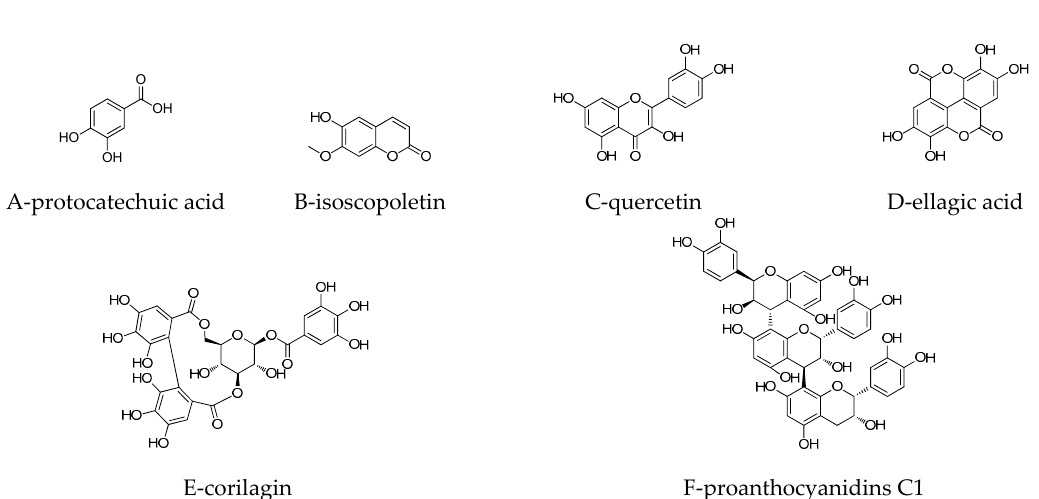
Figure 2. Chemical structures of LPPs in purified LPE.